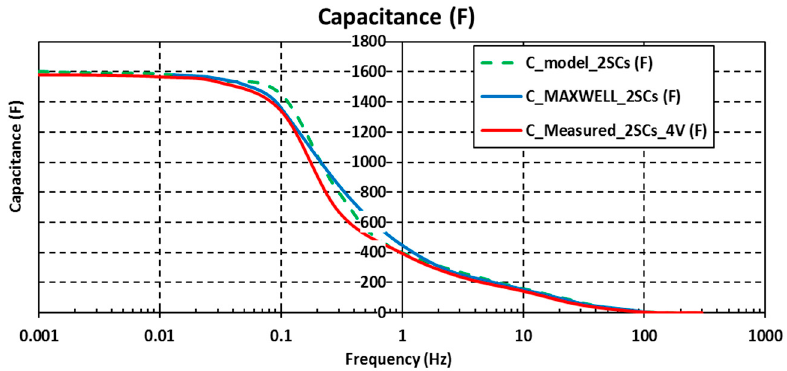
Figure 17. Comparison in the frequency response of the measured capacitance and the value obtained from the electrical circuit model of the two SCs charged to 2 V. The capacitance value provided by the manufacturer is also plotted (blue line).